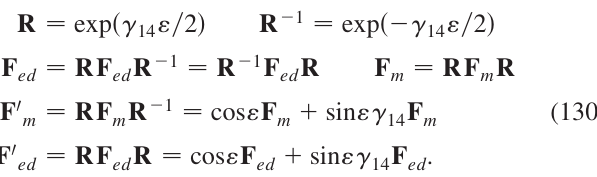
¼ (cid:1) a (cid:1) b (cid:2) (cid:1) b (cid:1) a , where a is the index of the row, b the index of the column, c 2 ¼ 1 . 15